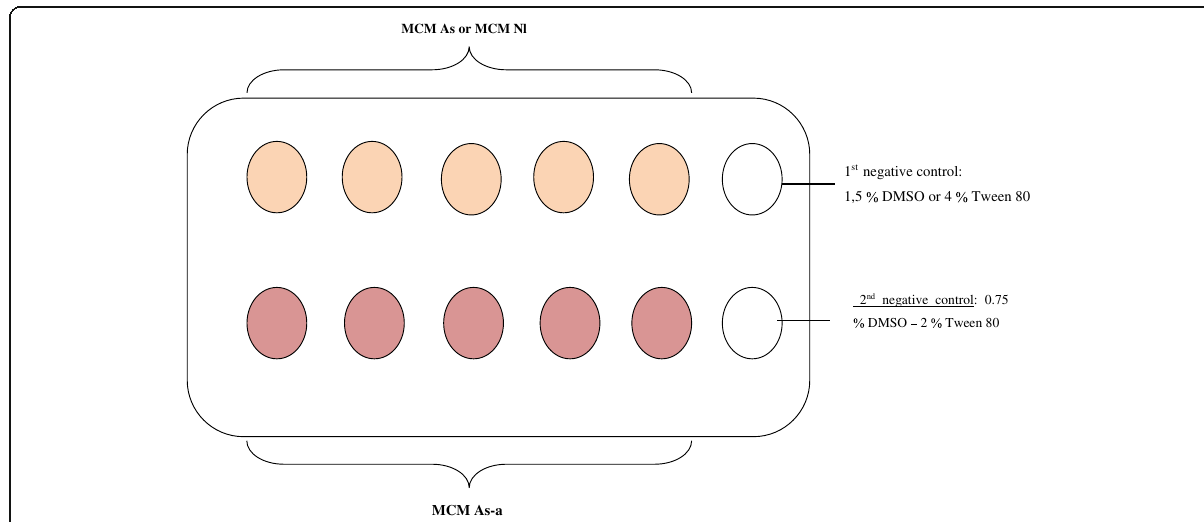
Fig. 1 Experimental design.. Legend: MCM As = Methylene Chloride-Methanol extract of Annona senegalensis . MCM Nl = Methylene Chloride- Methanol extract of Nauclea latifolia MCM As-Nl = Methylene Chloride-Methanol mixture of extract of Annona senegalensis and Nauclea latifolia. DMSO: